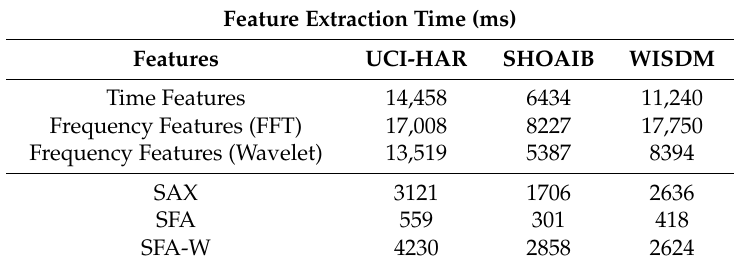
Table 5. List of processing time for feature extraction step in time, frequency, and discrete